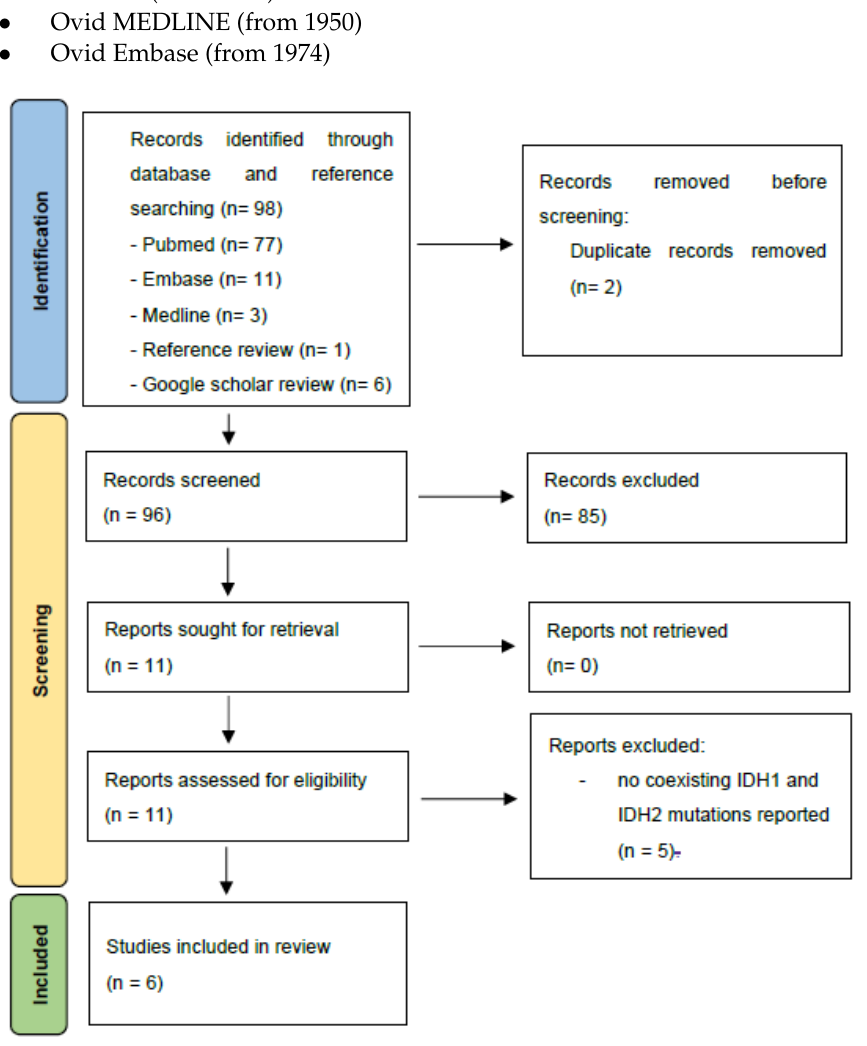
Figure 2. Systematic literature review strategy—PRISMA flowchart of record inclusion